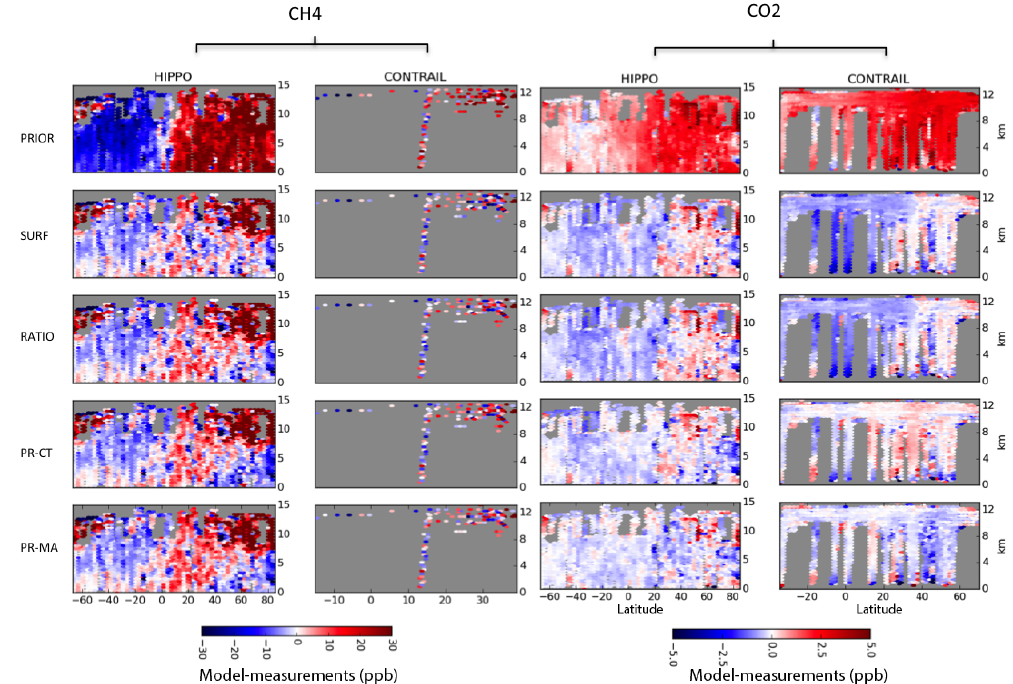
Figure 8. Validation of inversion-optimized concentration fields of CO 2 and CH 4 with airborne measurements.